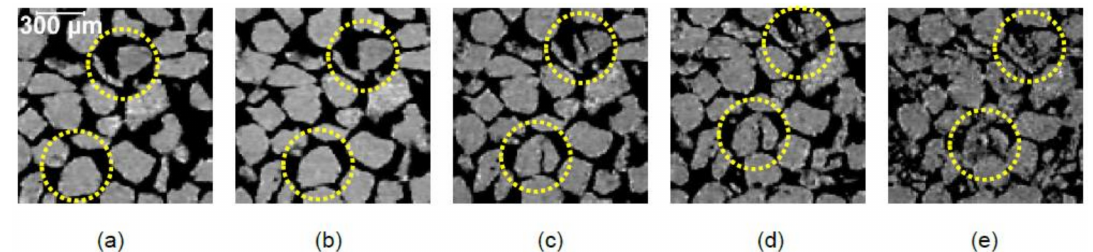
Figure 13. Crushing of RBS particles with increasing vertical stresses: ( a ) no-load; ( b ) 8 MPa; ( c ) 16 MPa; ( d ) 32 MPa; ( e ) 64 MPa.